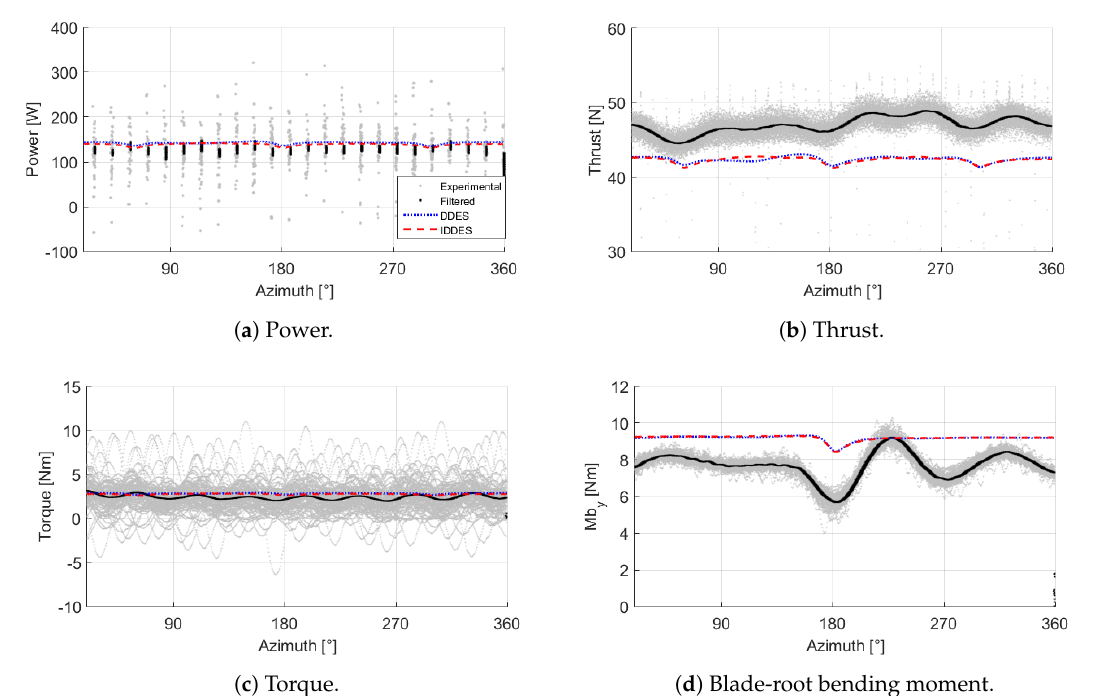
Figure 6. Comparison between Delayed Detached Eddy Simulation (DDES) and Improved DDES (IDDES) turbulent approach of the integral quantities.